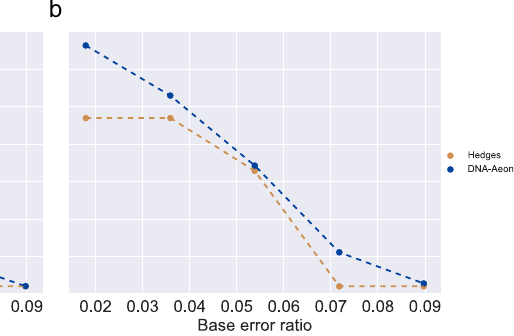
constraints of a GC content of 33 : 3% to 66 : 6% in 12 bp long intervals and a max- imum homopolymer length of 4. Points represent the results of the simulations, while dashed lines are interpolated values. Source data are provided as a Source Data fi le.